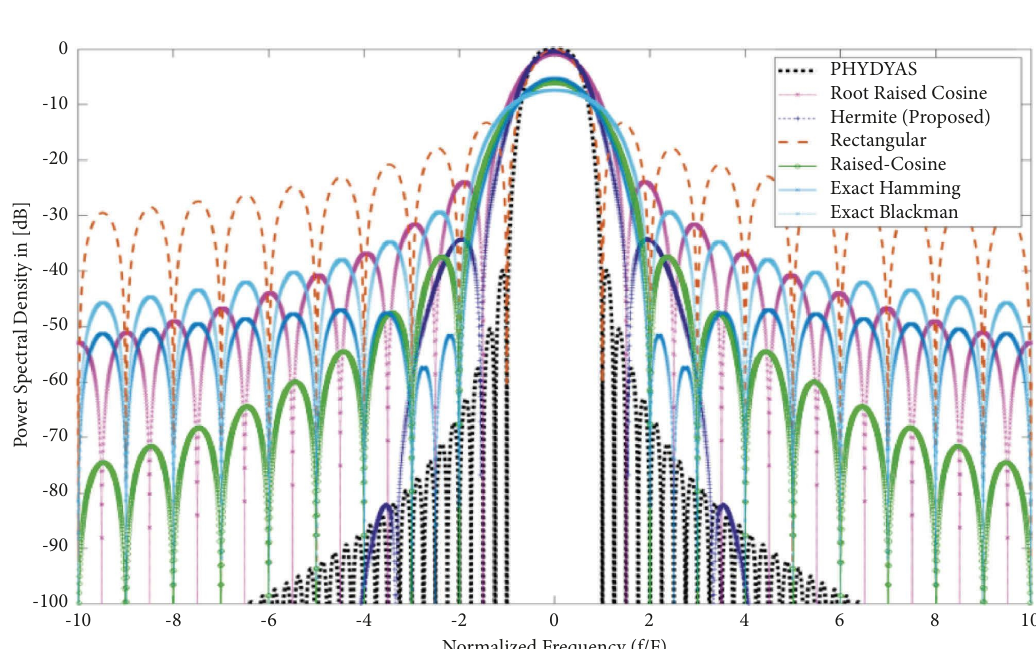
Figure 6: Power spectral density versus normalized frequency of diferent prototype flters for subcarrier spacing of 15 kHz and number of subcarriers of